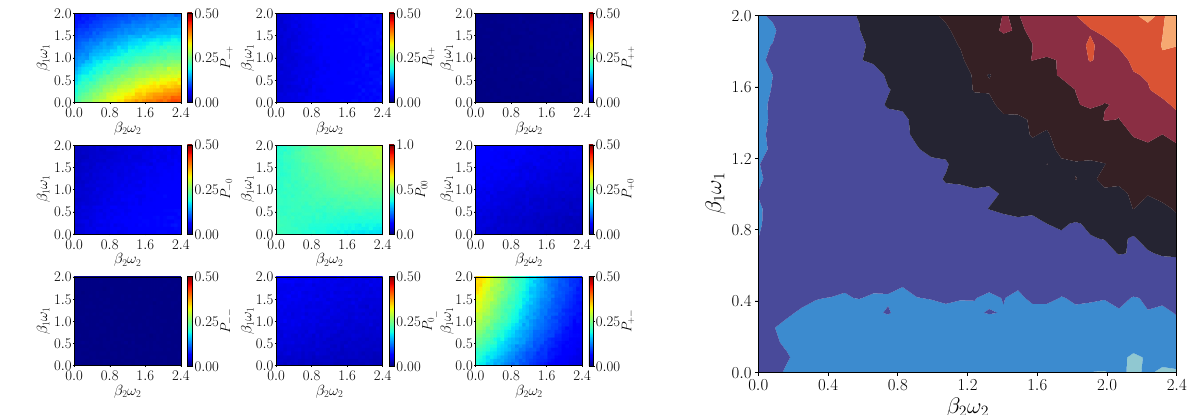
FIG. 9. Measured values of (cid:5) e − β m ,1 (cid:10) E 1 − β m ,2 (cid:10) E 2 (cid:2) for the SWAP engine in Fig. 7 as a function of nominal inverse rescaled temperatures β 1 ω 1 , β 2 ω 2 .